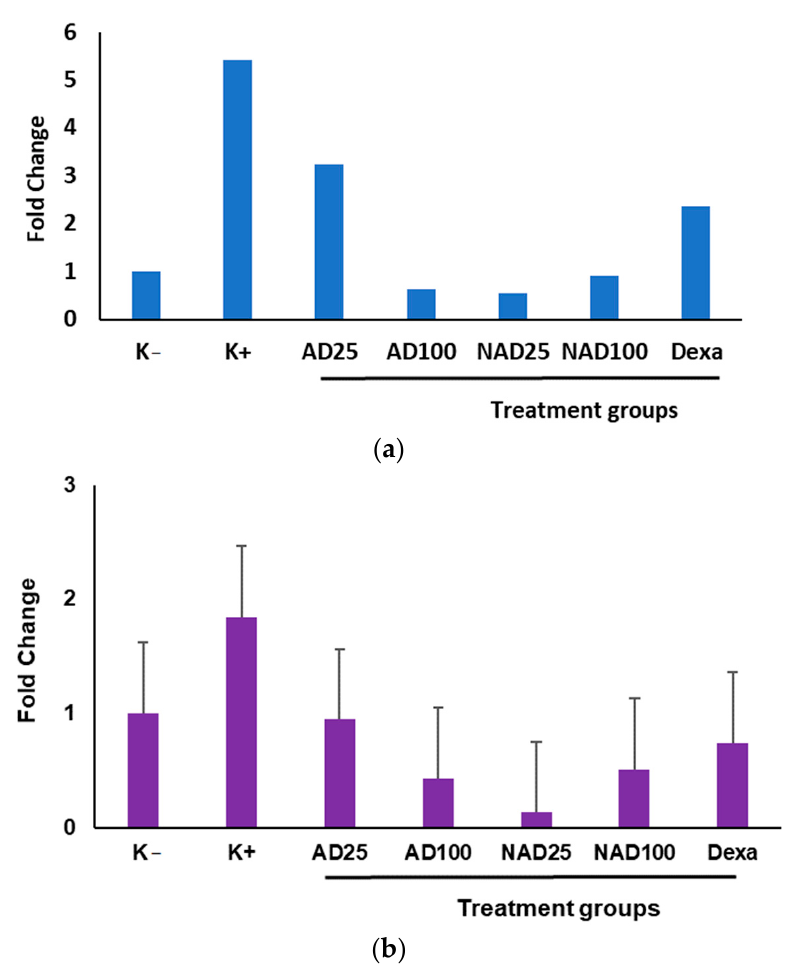
Figure 2. Effect of andaliman extract and nanoandaliman on gene expression of inos ( a ) and mmp1 ( b ) from brain in CFA-induced mice. Samples were andaliman extract (25 and 100 mg/kg bw; AD25, AD100) and nanoandaliman (25 and 100 mg/kg bw; NAD25, NAD100). Dexamethasone (15 mg/kg bw; Dexa) was used as a reference anti-inflammatory drug. K − , untreated mice; K+, mice treated with CFA. p:0.129 (for inos and mmp1 ) was determined by Kruskal-Wallis and continued by step- wise step-down post hoc test. There is no difference between Fc value and treatment groups. All